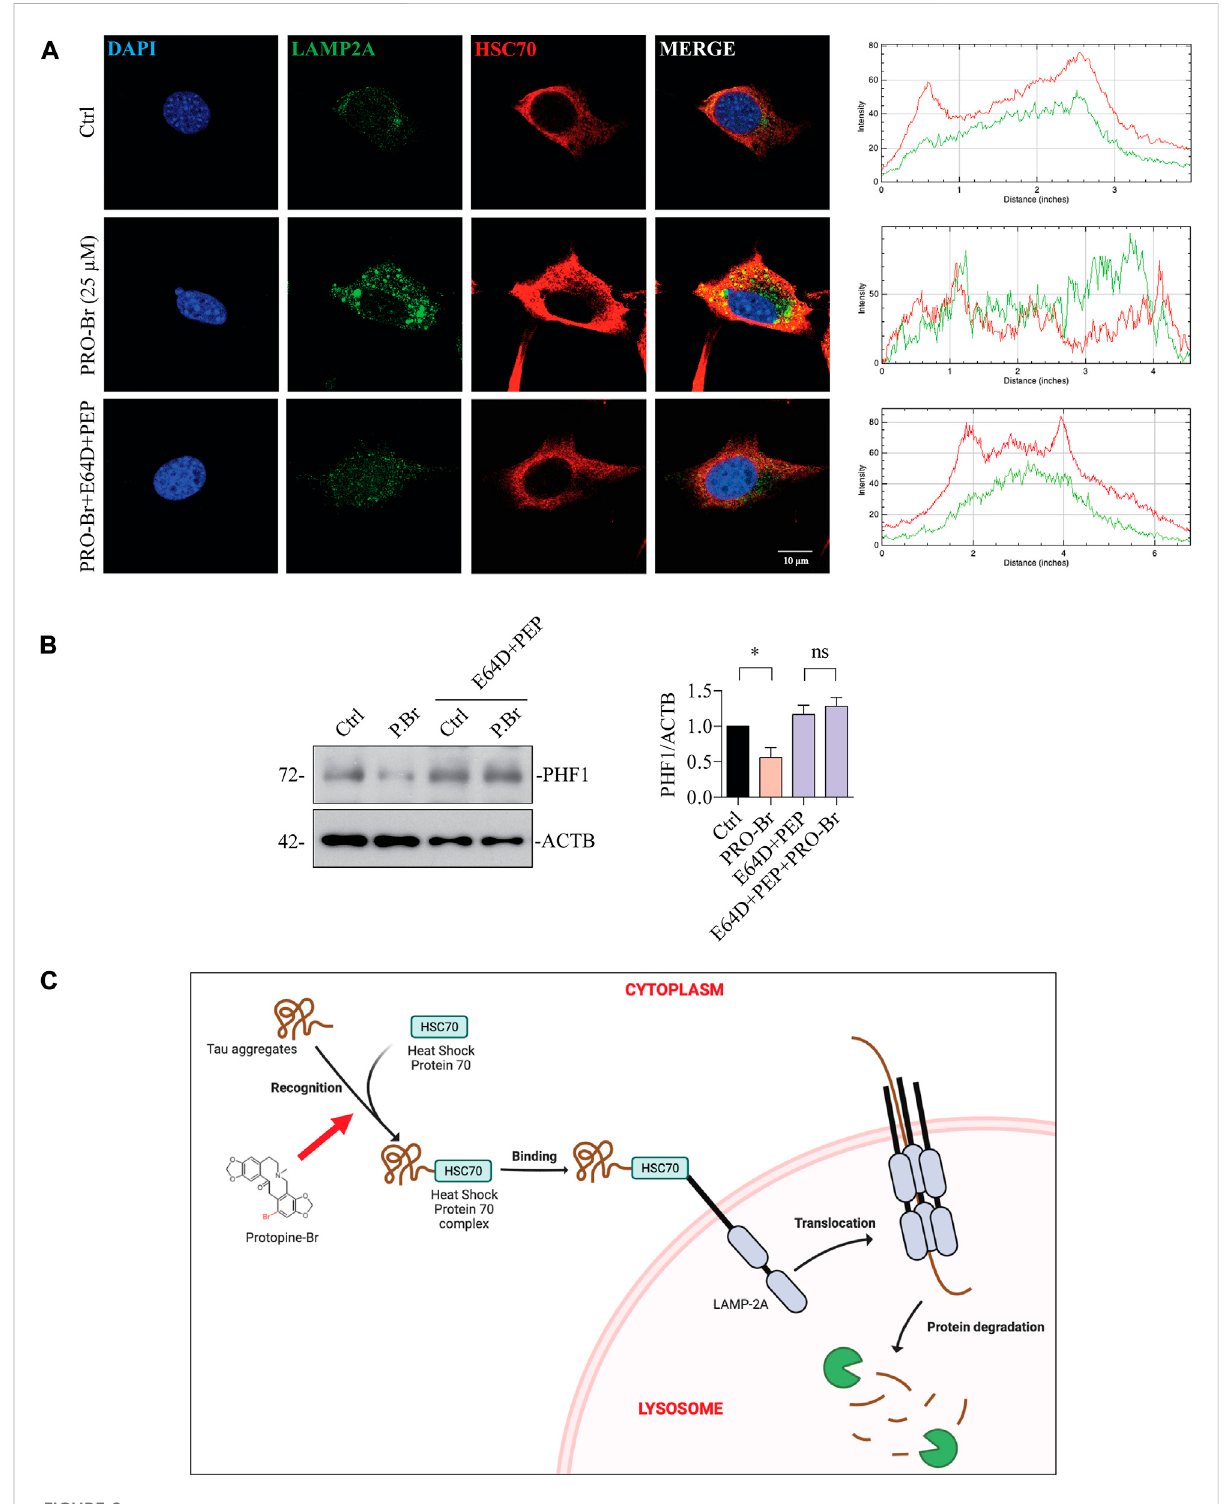
FIGURE 8 PRO-Br promotesthe degradation ofpathological tau via chaperone-mediated autophagy. In HT22 cells, (A) PRO-Br promotesthe interaction betweenheat-shockproteincognate71,HSC70andlysosomalmembraneprotein,LAMP2Aanditsquanti fi cation.HSC70isshowninred,LAMP2Ais shown in green, DAPI is shown in blue, and the interaction is shown in yellow. In SHSYP301L cells (B) PRO-Br-mediated degradation of PHF1 was blockedinthepresenceofCMA/lysosomalproteaseinhibitors(E64D+PEP).Datawasquanti fi edusingImageJsoftware,* p < 0.05andns=not signi fi cant. Data are represented as mean ± SEM of three replicates. (C) Proposed graphical representation of the neuroprotective mechanism of PRO-Br. PRO-Br clears hyper-phosphorylated and aggregated tau via the activation of chaperone-mediated